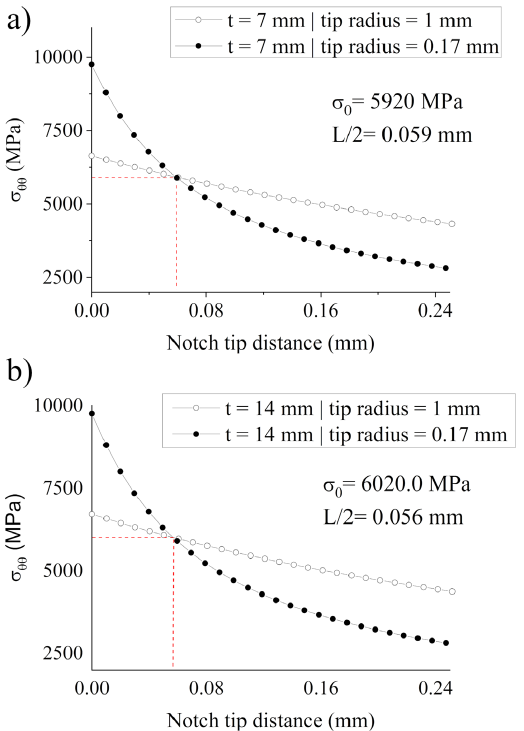
Figure 12. Stress field analysis according to PM: (a) thickness of 7 mm and (b) thickness of 14 mm.